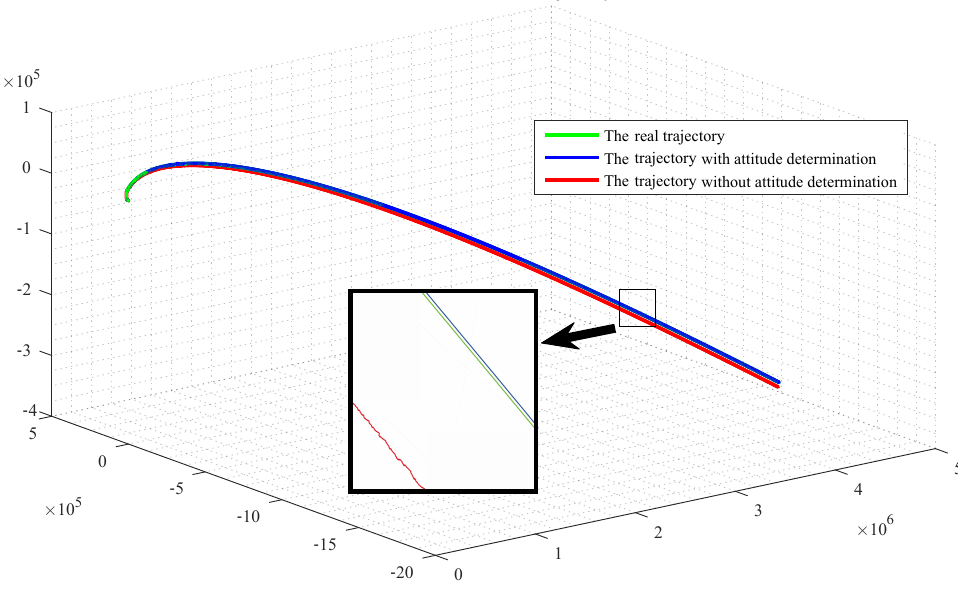
Figure 11. The Influence of the attitude determination on the accuracy of aircraft